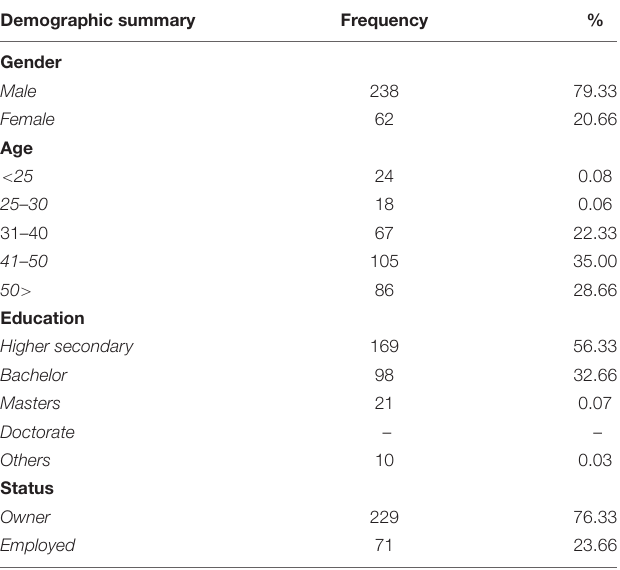
TABLE 1 | Demographic